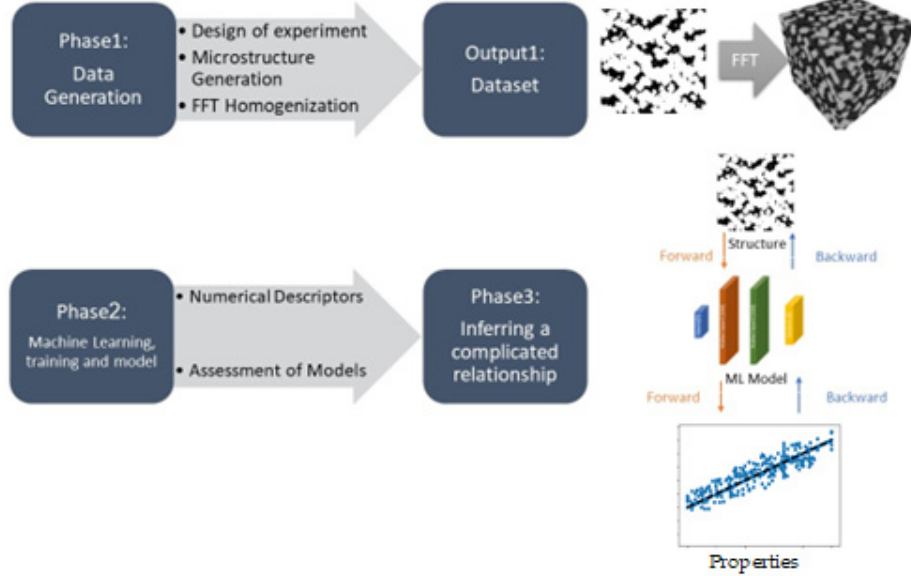
Figure 1. Overview of our study using an ML model for predicting the properties (forward links) and inverse design (backward links) of the studied material system, tungsten–copper composites.